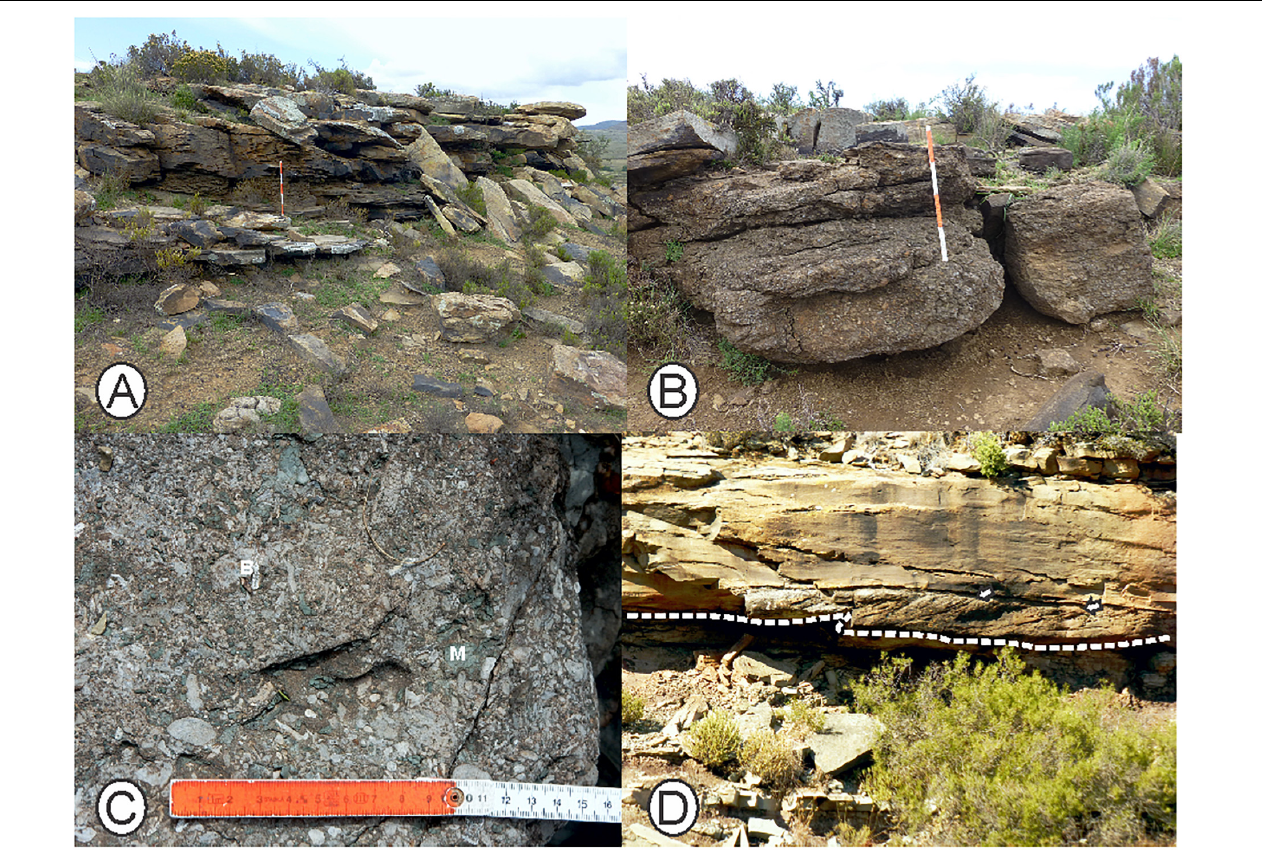
FIGURE 5 | Field images of intraformational PNC lag deposits. (A) 0.5 m thick lenticular deposit overlying an erosional base of the lowermost correlative sandstone in the area of Tweefontein 1 ( Figure 4 ). Scale in dm and cm. (B) ∼ 1.0 m thick lenticular PNC in same area as (A) showing low angle crossbeds and surficial weathering coloration. Scale in dm. (C) Surface exposure of PNC in which greenish-gray mudchips (m) and vertebrate bone (b) are mixed with pedogenic nodules of various shapes and sizes. Scale in cm. (D) 1.0 m thick PNC lag exhibiting sigmoidal cross bedding. (A–C) S31.82372 ◦ , E024.81617 ◦ ; (D) S31.76592 ◦ , E024.84473 ◦ .